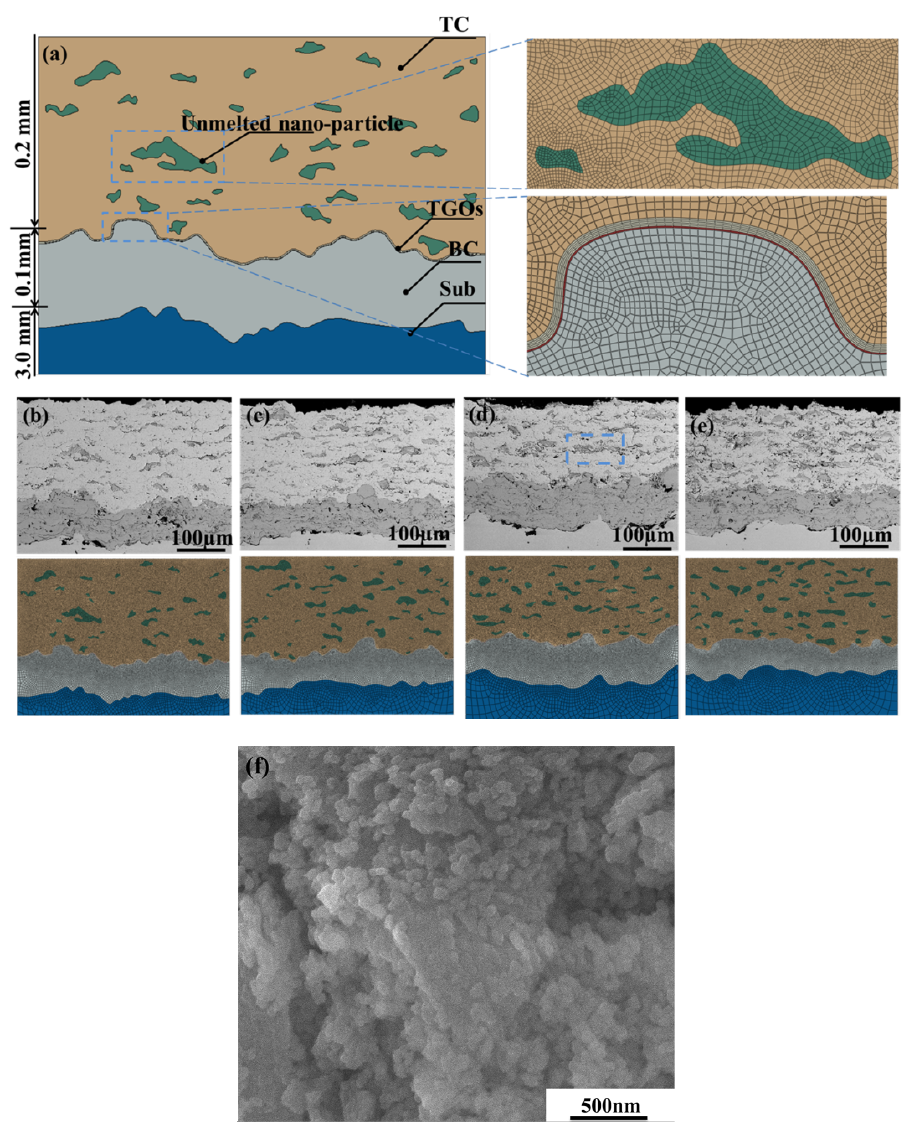
Figure 1. ( a ) Finite element model of thermal barrier coatings (TBCs) system and a detailed finite element mesh in the top coat (TC) and thermally grown oxide (TGO)/TC interface; ( b ) cross-sectional SEM image and corresponding model of NC1 with 11% unmelted nano-particle content (UNCs) ; ( c ) cross-sectional SEM image and corresponding model of NC2 with 15% UNCs; ( d ) cross-sectional SEM image and corresponding model of NC3 with 22% UNCs; ( e ) cross-sectional SEM image and corresponding model of NC4 with 34% UNCs, ( f ) the detailed morphology of unmelted nano-particles in NC3.